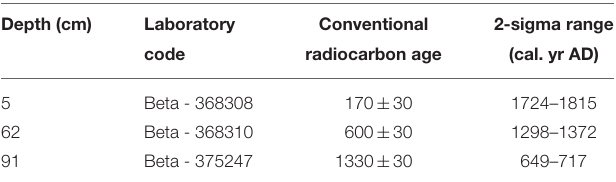
TABLE 1 | Radiocarbon calibrated dates calculated from CLAM v. 2.2 in R computer program (Blaauw, 2010) and the data set INTCAL13 (Reimer et al., 2013) used to develop the chronology for S1M1 core at Cuyutlan Lagoon, west-central,